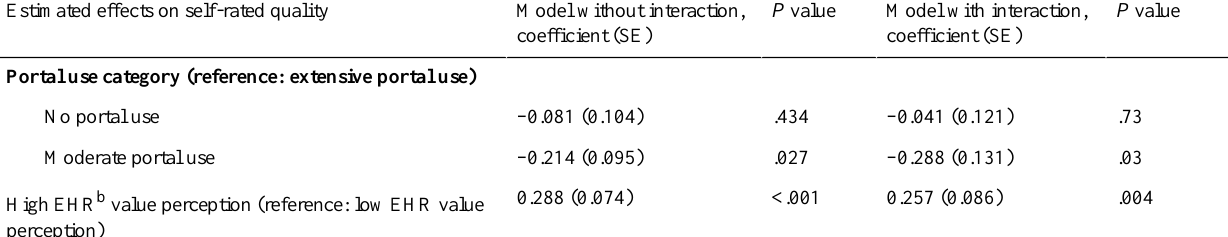
P valueModel with interaction,